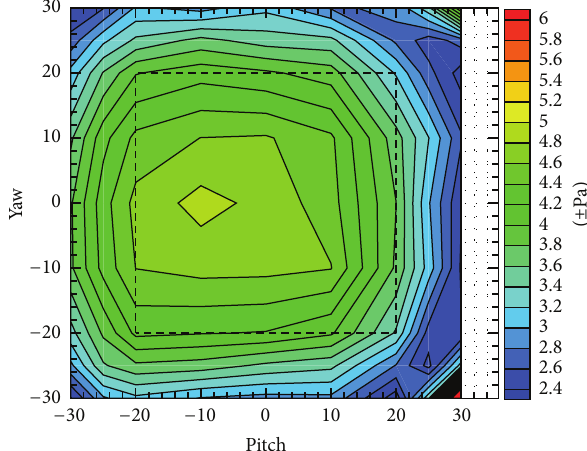
Figure 12: Static pressure uncertainty at 20 m/s, 81 (9 × 9) points (in terms of ± Pa).